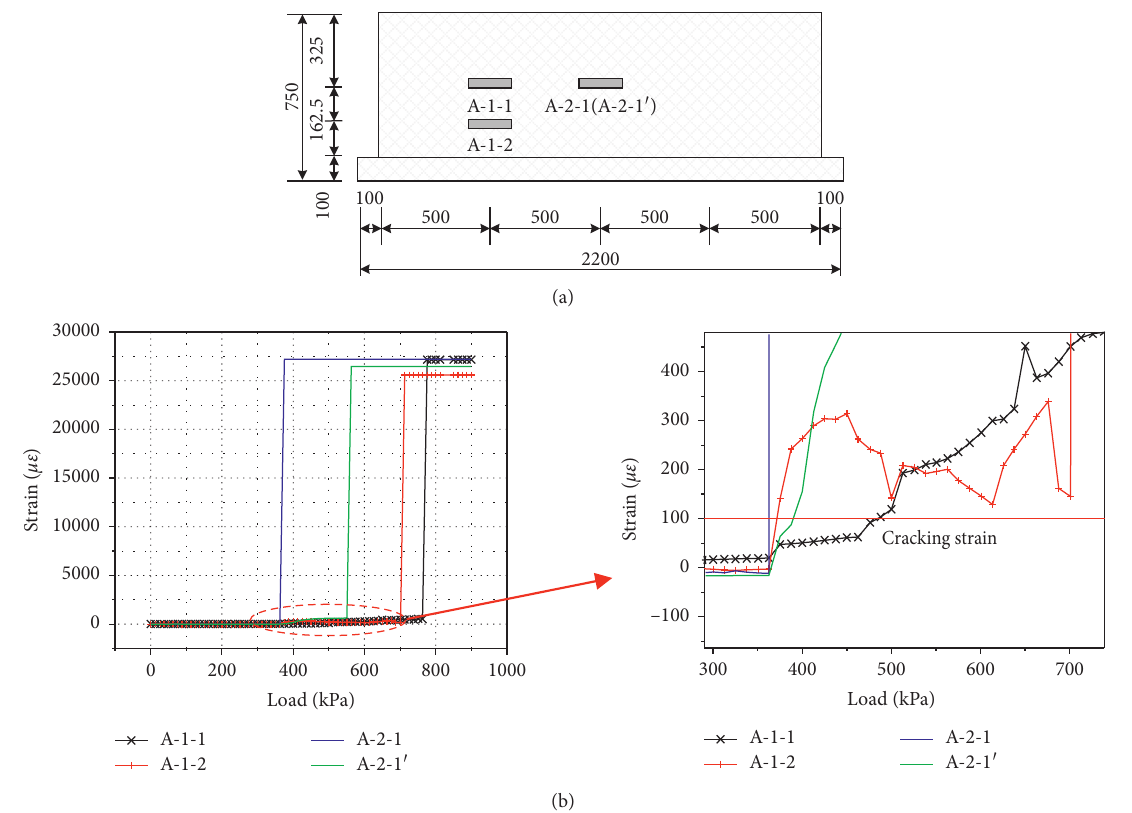
Figure 10: Strain evolution of A2. (a) Measuring points of cover concrete. (b) Load-strain curve.